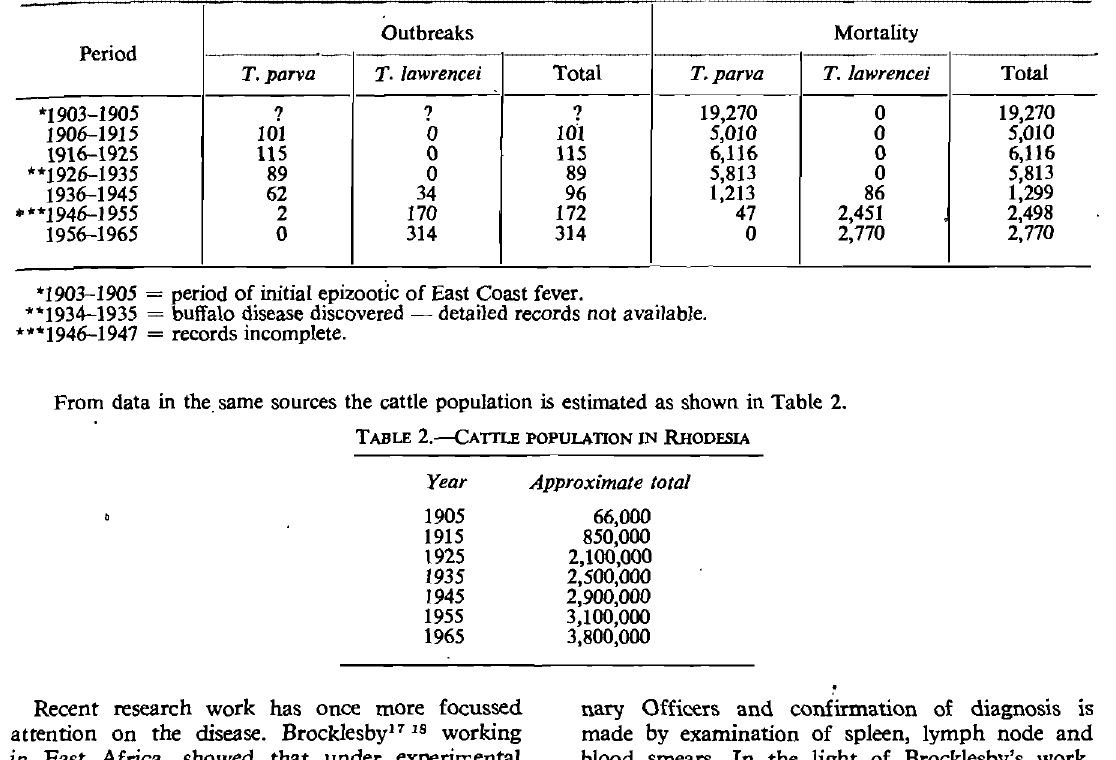
TABLE l.-THEILERIOSIS OUTBREAKS AND MORTALITY